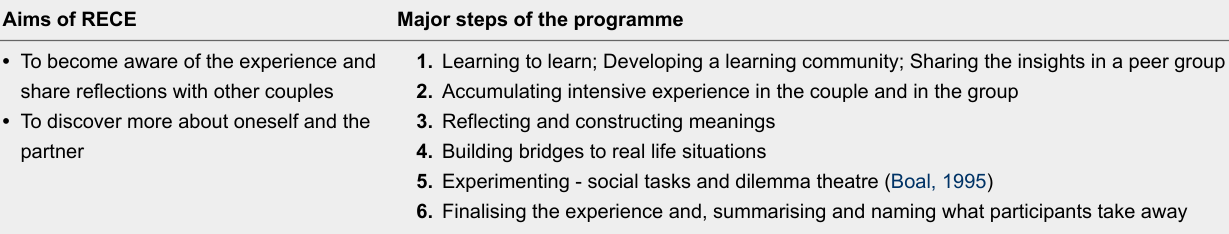
The Reflective Experiential Couple Education Framework